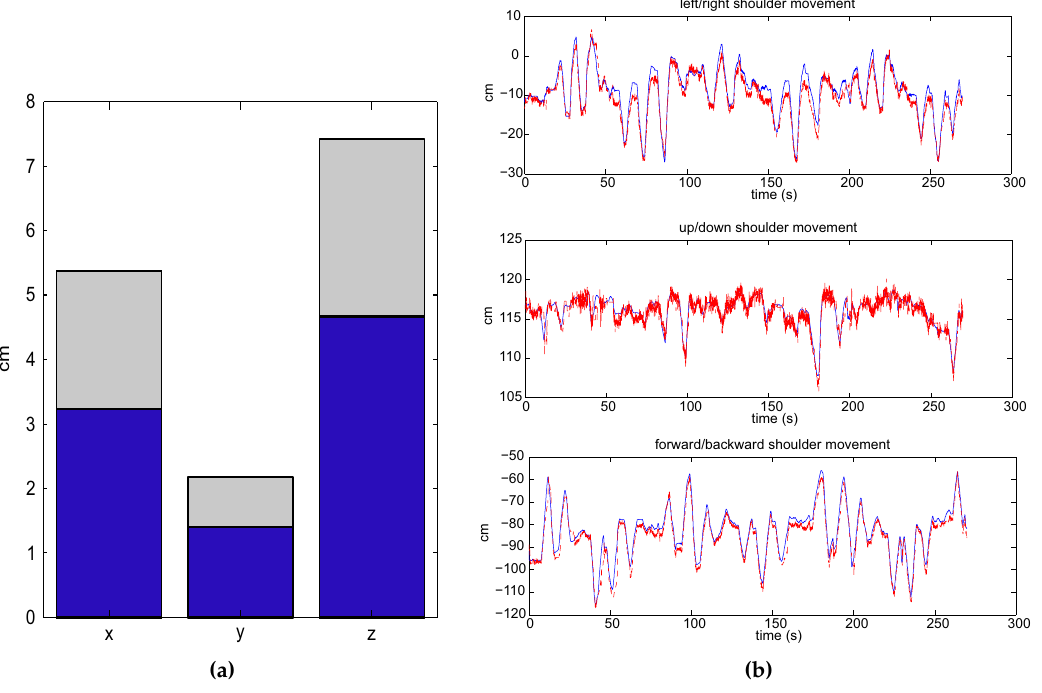
Figure 8. Shoulder movement in the compensation trial. ( a ) Mean RMSE (blue bar) committed by the population and the standard deviation (gray bar): x, left/right movements; y, forward/backward movements; z, up/down movements; ( b ) Estimated movement through the proposed algorithm (dotted red line) and the direct movement (blue line) performed by one